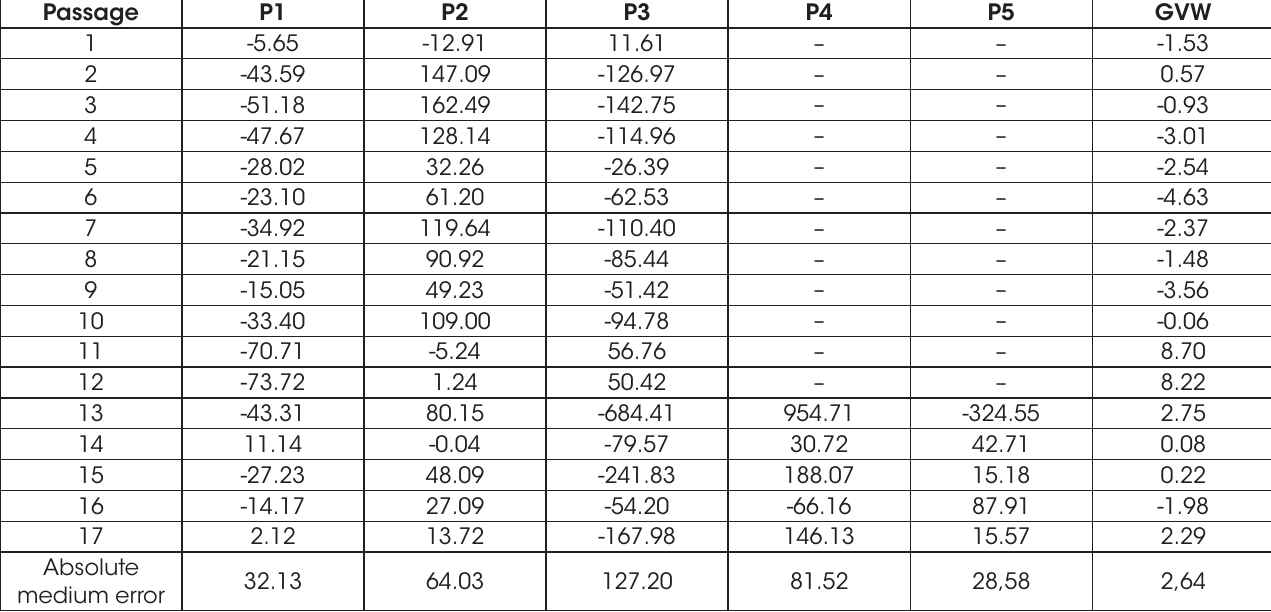
Errors (%) acquired for the passages of the calibration vehicles on lane 1